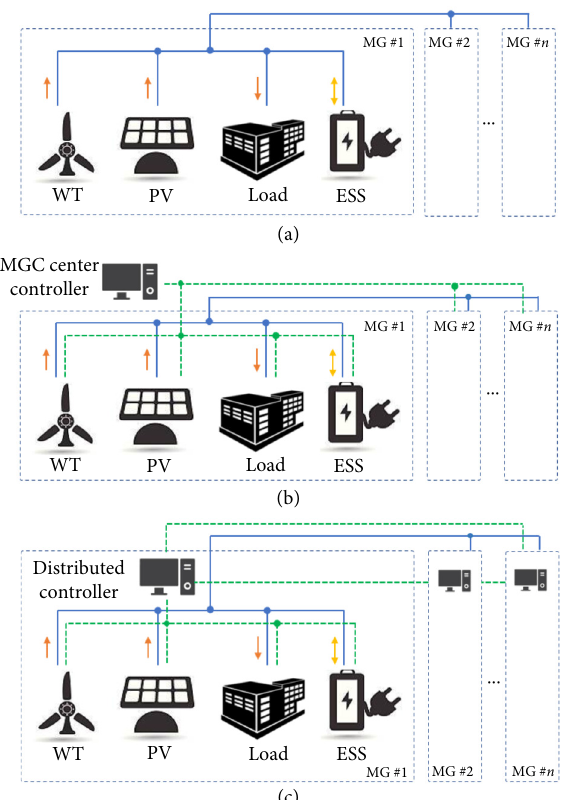
Fig. 3 Operation architecture of multiple microgrids: (a) decentralized architecture, (b) centralized controller, and (c) distributed